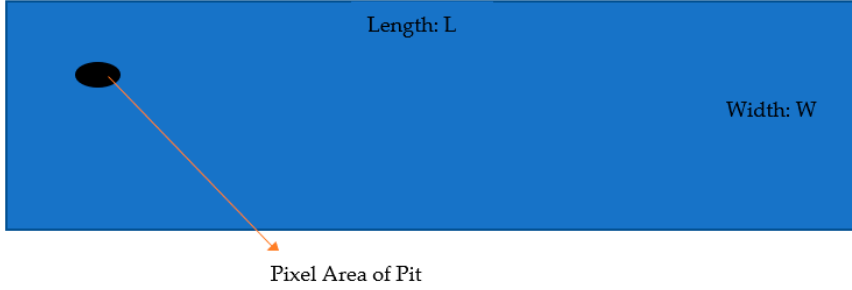
Figure 2. Schematic of plate and pit for area unit conversion.